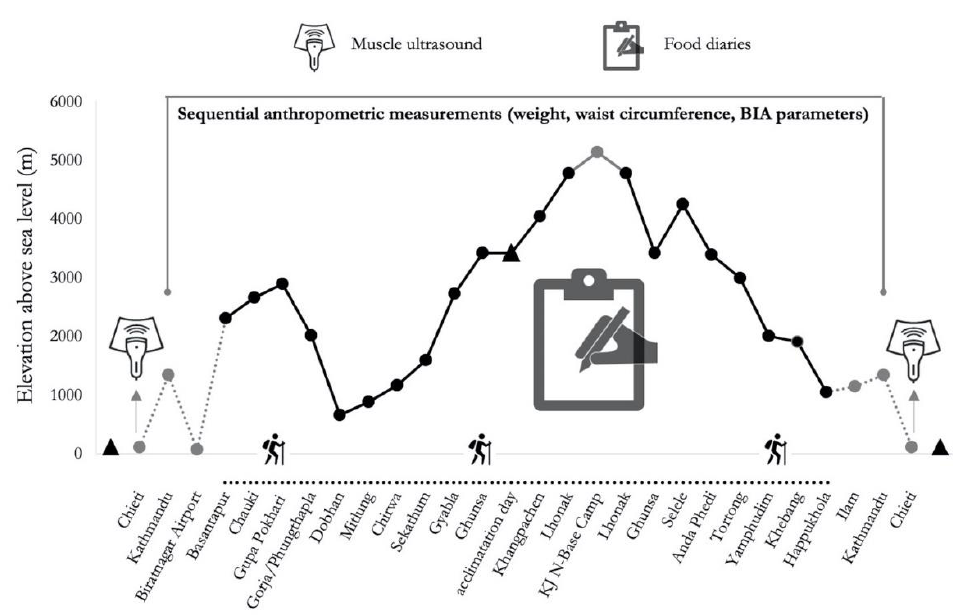
Figure 1. Altimetric scheme of the “Kanchenjunga Exploration and Physiology” project. The continuous line represents the effective trek. The plain data points represent the effective Himalayan trekking expedition. The empty circular data point at Kanchenjunga North Base Camp (KJ N-Base Camp) represents the highest altitude (5143 m) reached by participants throughout the trek.